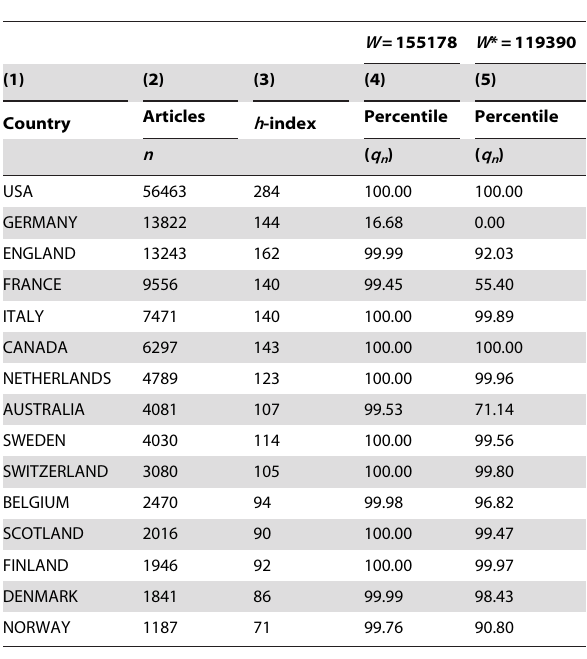
Table 2. Field of Clinical